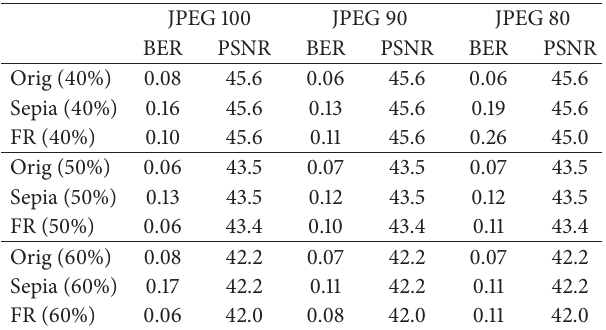
Table 2: The mean bit error rate of the final template and the mean peak signal-to-noise ratio [dB] of the watermarked image for different JPEG quality